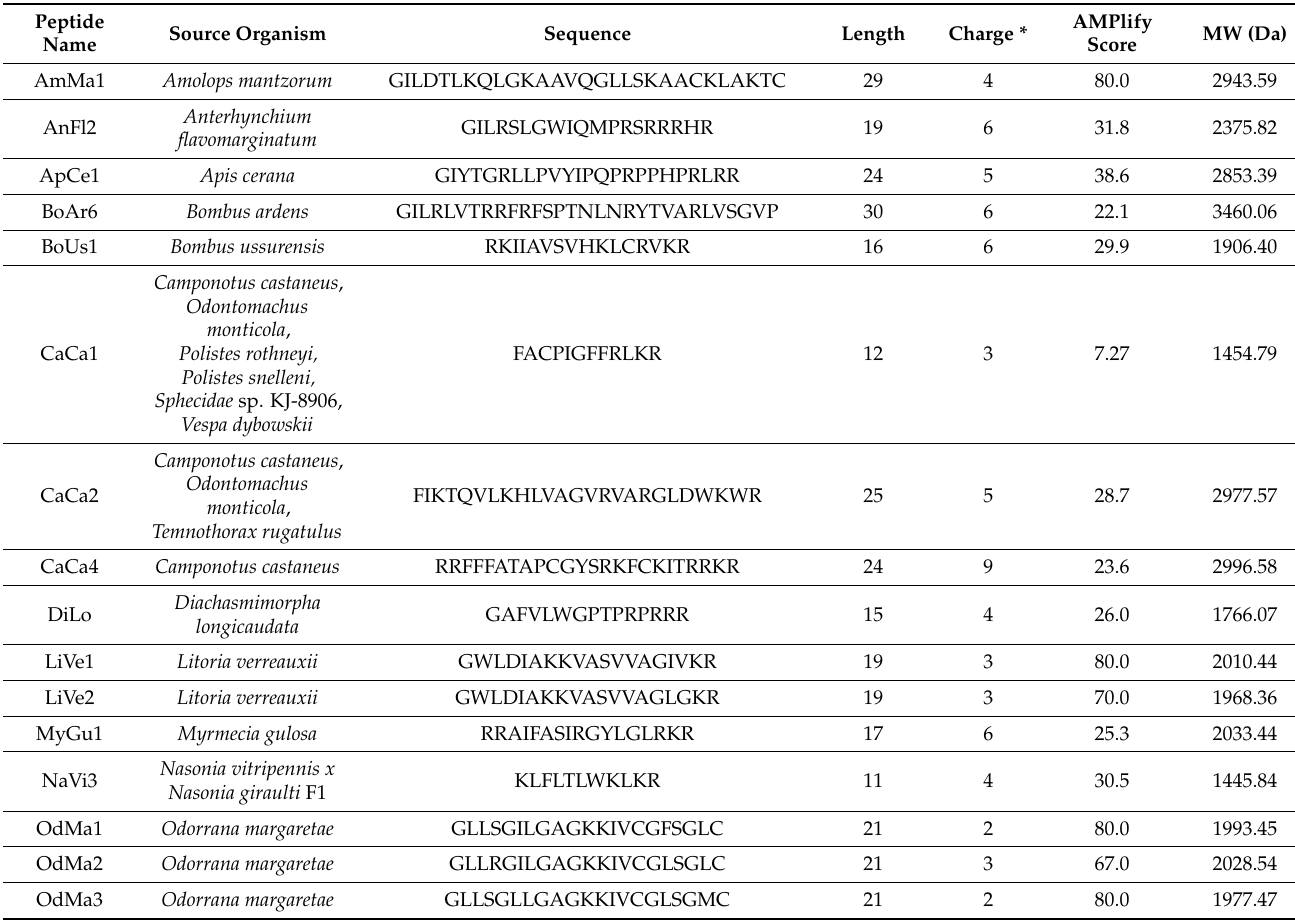
Table 1. Sequences and physiochemical properties of the 51 bioactive AMPs discovered using